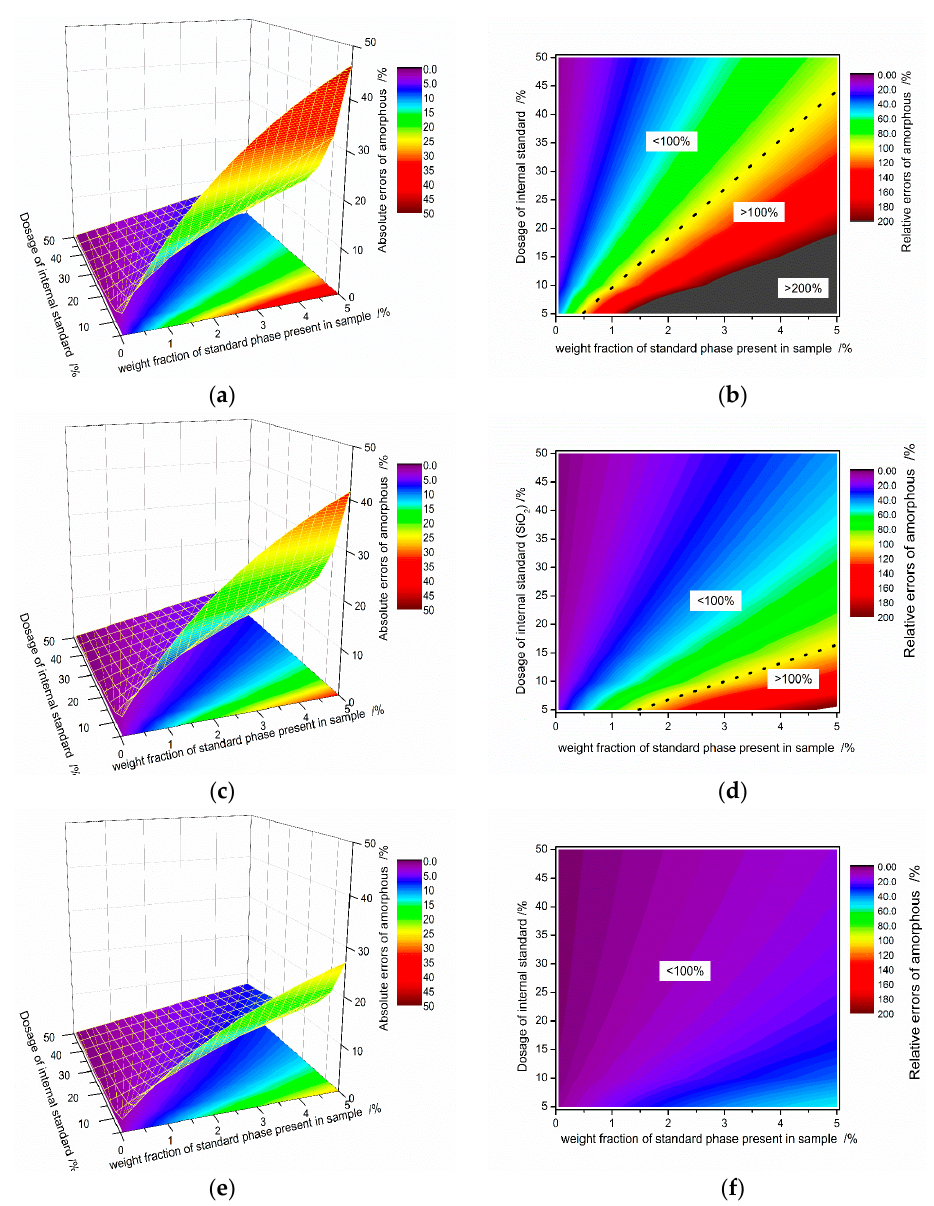
Figure 4. Absolute and relative errors analysis of amorphous phase. ( a , c , e ): the absolute error distribution in which the content of amorphous phase is assumed to be 10%, 20%, and 50%, respectively; ( b , d , f ) The corresponding 2D relative errors patterns of ( a , c , e ), respectively.